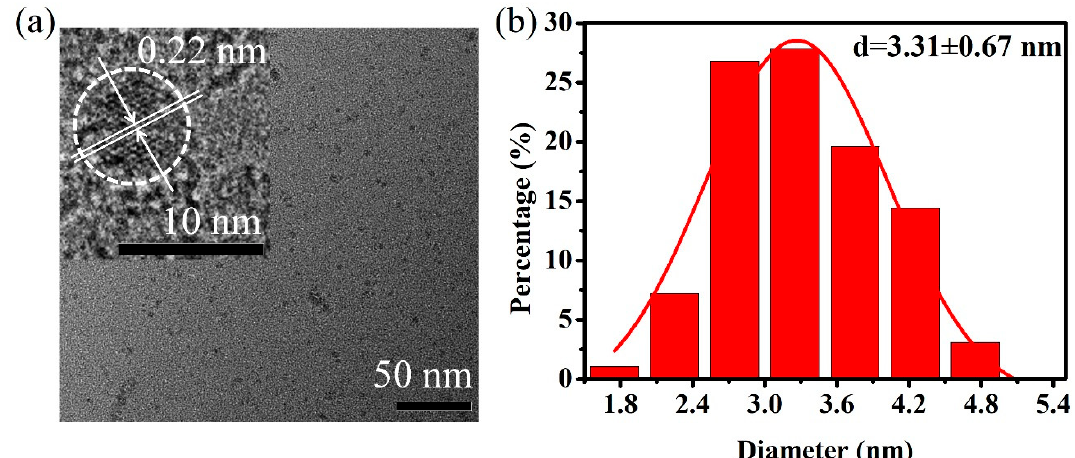
Figure 2. ( a ) Transmission electron microscopy (TEM) image and ( b ) size distribution of g-CQDs, inset of (a) is the high resolution TEM image. (V (EDA) = 4 mL, T = 180 °C, D r = 12 h).